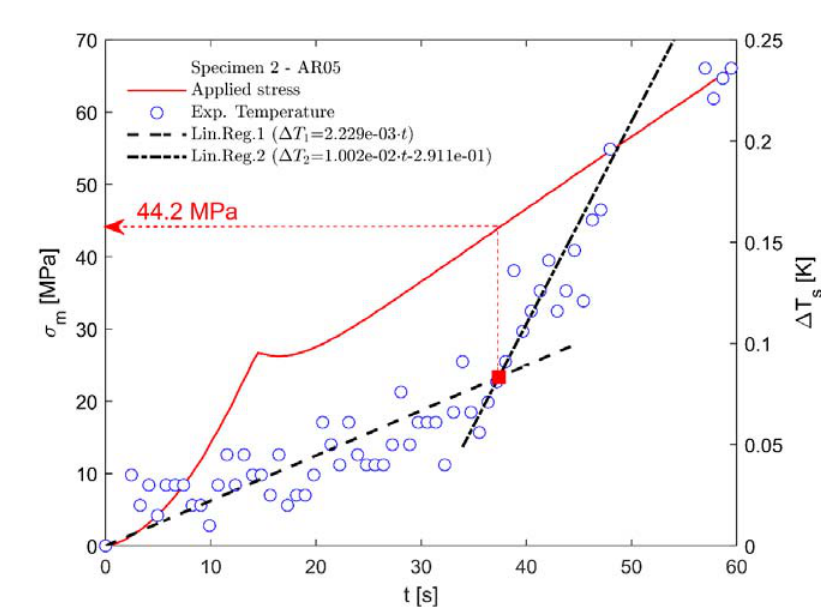
Figure 7:  T vs time curve (blue points) and stress vs time curve (red line) for area AR05 of Specimen